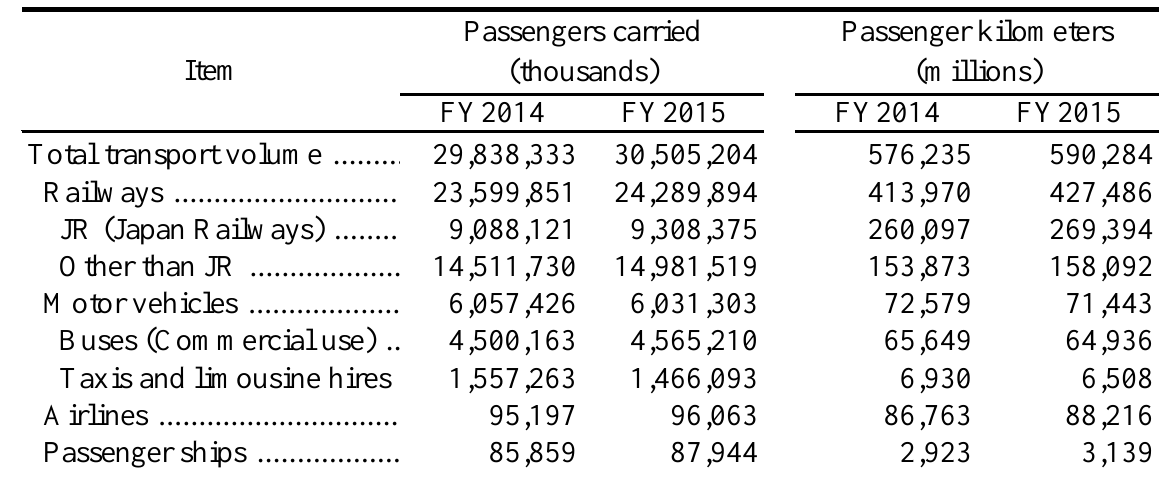
Domestic Passenger Transport